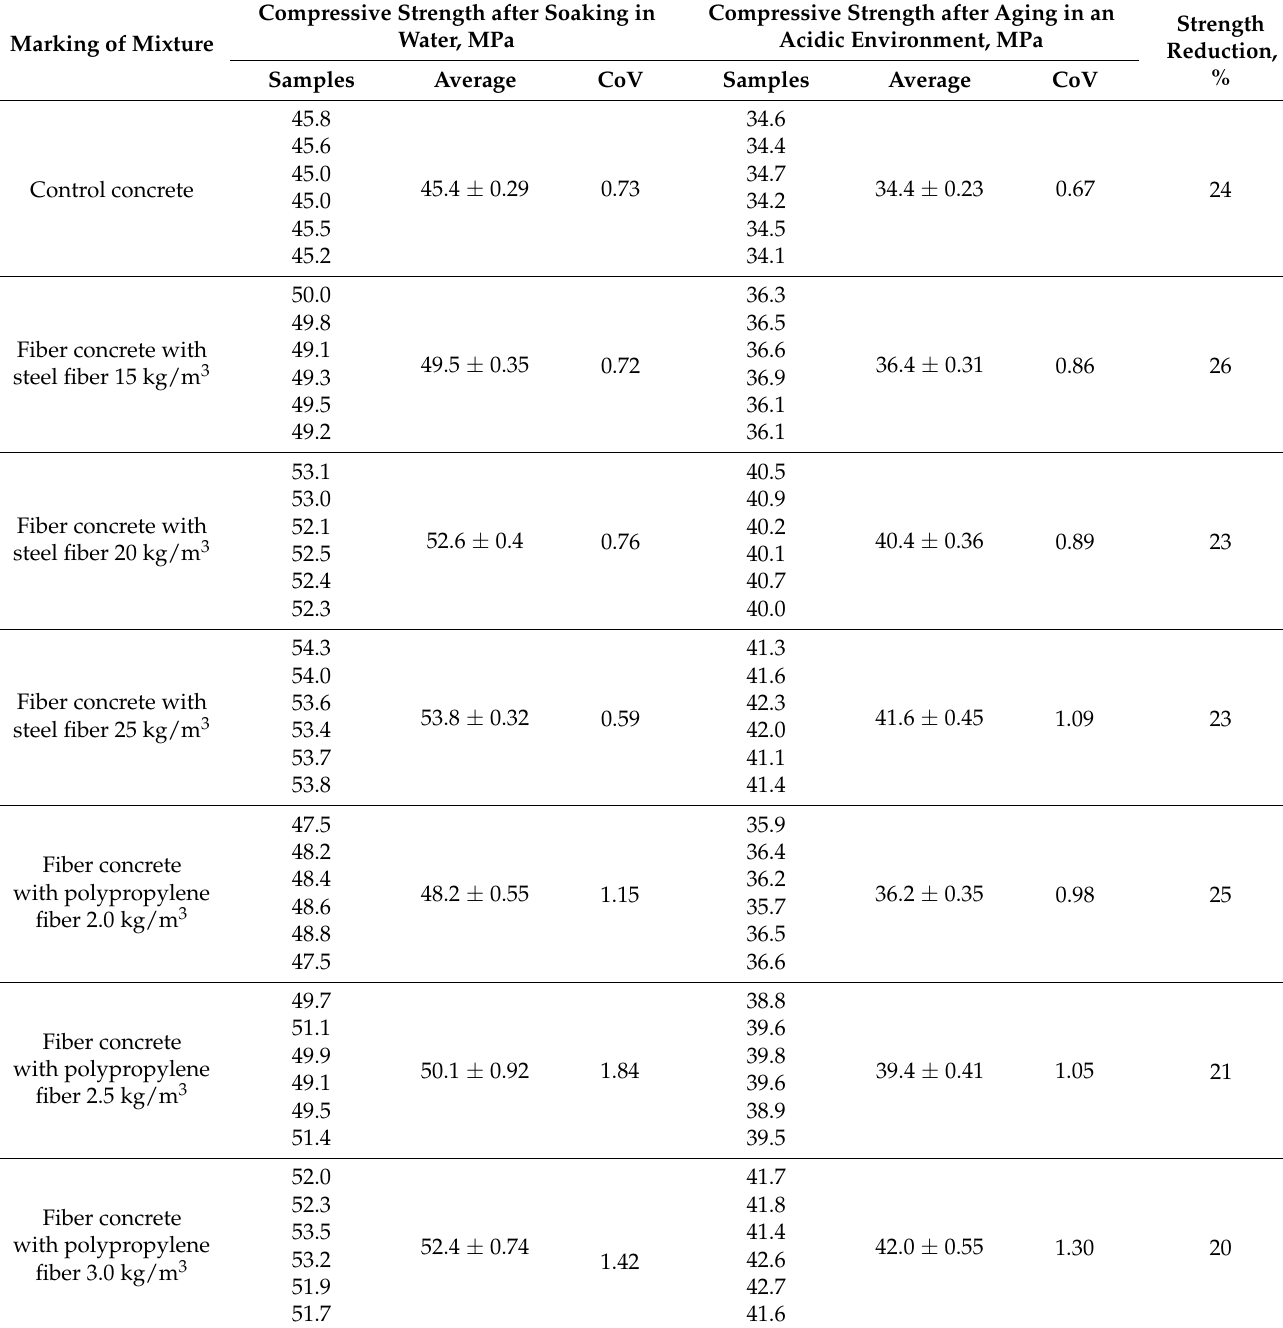
Table 4. Strength of concrete and fiber-reinforced concrete after 6 months exposure to water and in an acidic environment (‘ ± ’ indicates standard deviation, ‘CoV’ indicates coefficient of